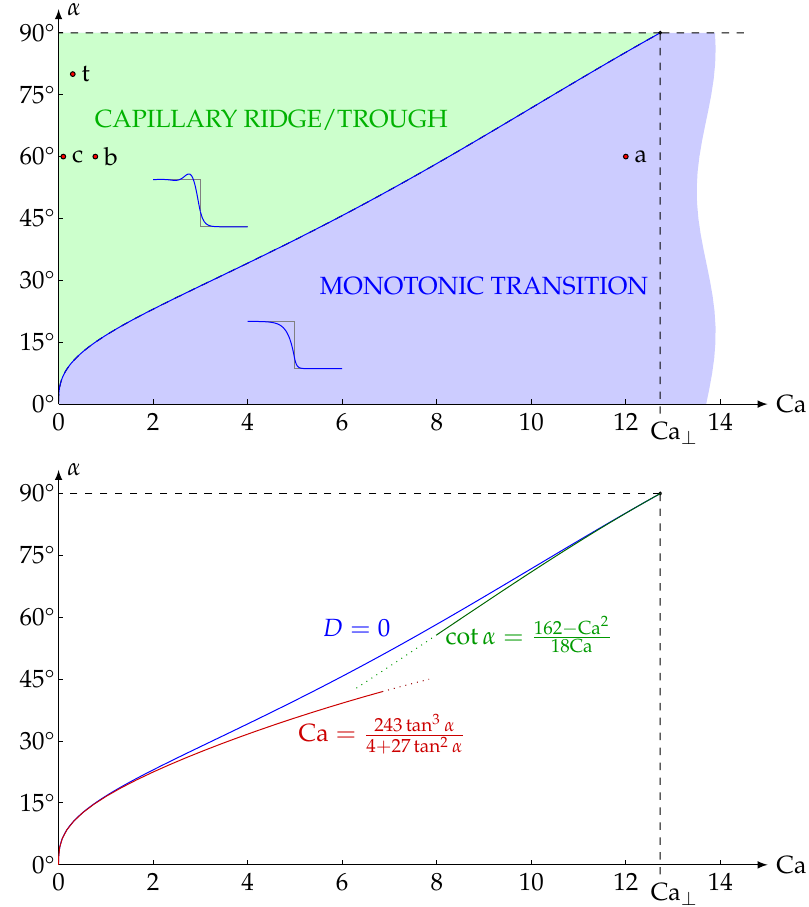
Figure 7. Upper plot : characteristic parameter map for α against Ca identifying the regions associated with (i) a monotonic transition of the free surface disturbance (blue region) and (ii) the occurrence of spatial oscillations with a dominant capillary ridge/trough (green region); the two regions being separated by a neutral limit curve along which the discriminant (A18) vanishes. The different step-up/-down cases, (a)-(c), explored in Figures 3 and 4 are identified by the labels a-c, respectively, the trench case considered in Figures 5 and 6 by the label t. Lower plot : Neutral limit curve (blue curve) compared with the corresponding curves obtained using the approximations (A26) and (A27), derived in Appendix A.5, when α is small (red curve) and close to 90° (green curve),